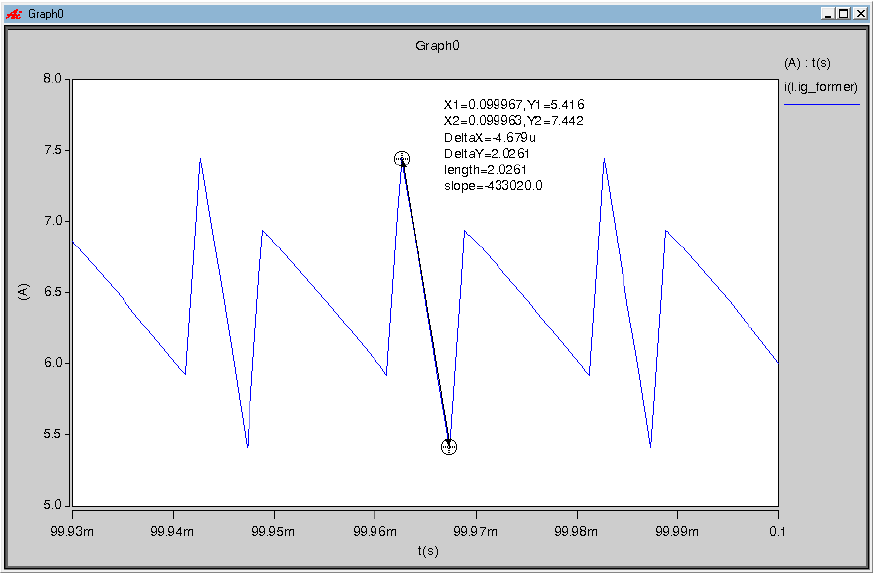
Figure 16. Zoom in the input current ripple for the former strategy when G = 5 . 9, D = 0 . 7663 ( k d = 0 . 5).